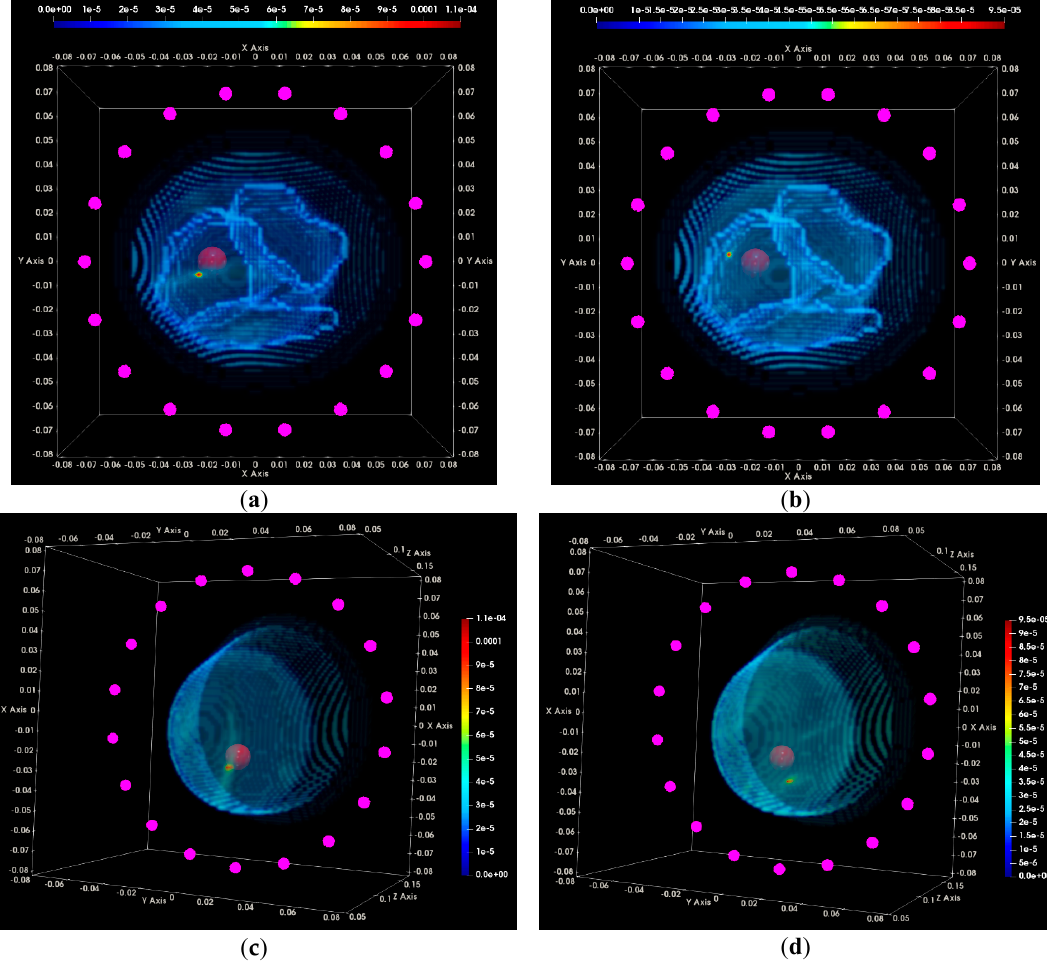
Figure 21. Breast rotational position #2—image in the interior of the breast only, formed at a single vertical position of the sensor network, in front of the tumor: ( a ) Test Date 1, top XY view, superposition of the fibroglandular and outer breast surface molds (blue color), red sphere indicating the tumor location; ( b ) Test Date 2, top XY view, superposition of the fibroglandular and outer breast surface molds (blue color), red sphere indicating the tumor location; ( c ) Test Date 1, 3D view, superposition of the outer breast surface mold (blue color), red sphere indicating the tumor location; ( d ) Test Date 2, 3D view, superposition of the outer breast surface mold (blue color), red sphere indicating the tumor location.